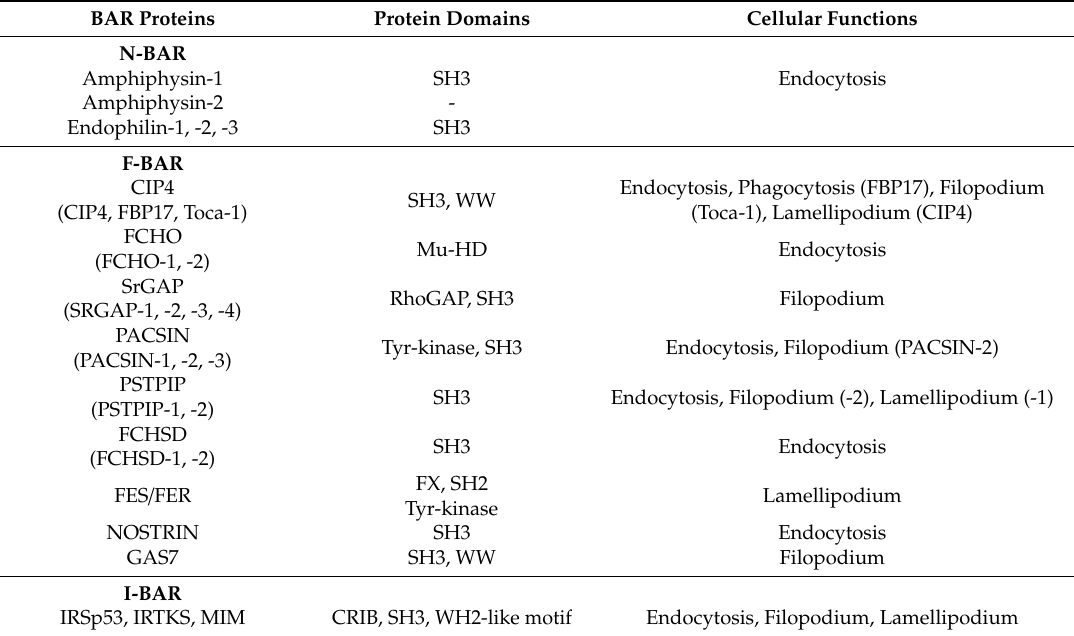
Table 1. N-, F- and I-BAR family domain structure and cellular functions. Adapted from [28]. BAR Proteins Protein Domains Cellular